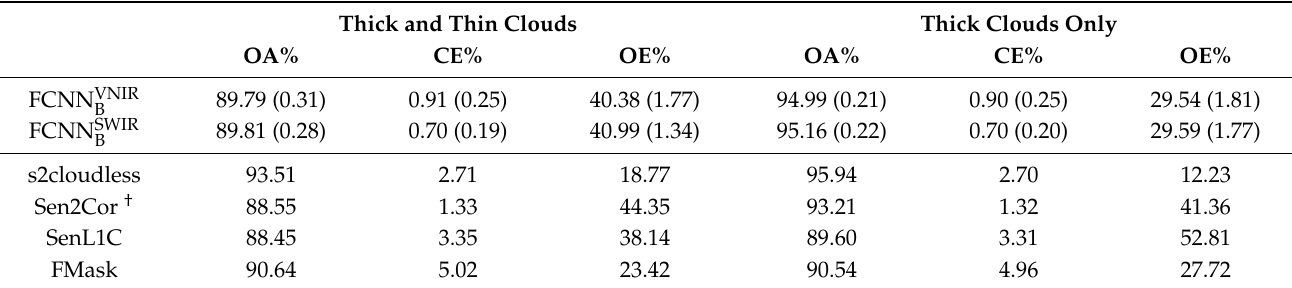
Table 6. Results of the FCNN B models, s2cloudless, and FMask evaluated on the S2-BaetensHagolle dataset. Thick and Thin Clouds Thick Clouds Only OA% CE%